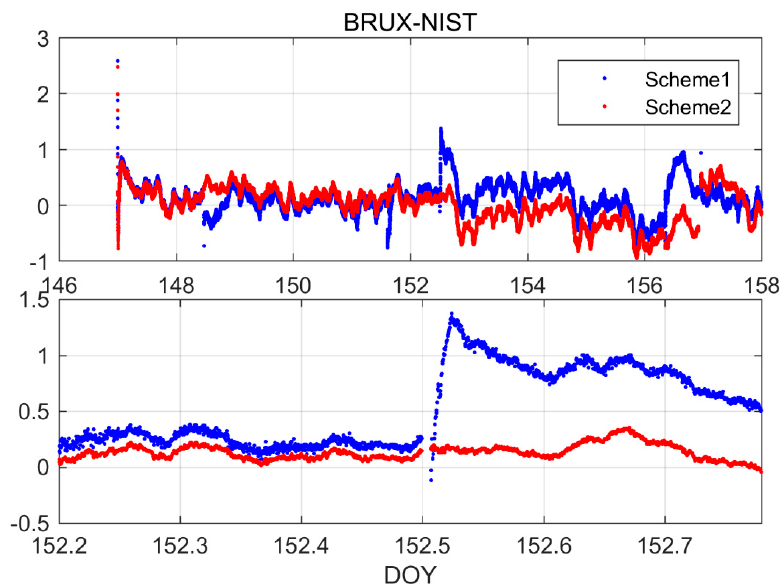
Figure 10. Clock offset time series of scheme 1 ( blue ) and scheme 2 ( red ); the yellow colour represents the solutions of the complete data with the between-epoch constraint model; the bottom figure is a partial amplification of the top figure.